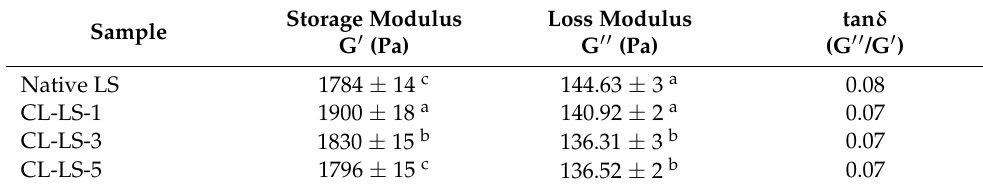
Table 3. Dynamic rheological properties of native and modified lotus seed starch. Sample